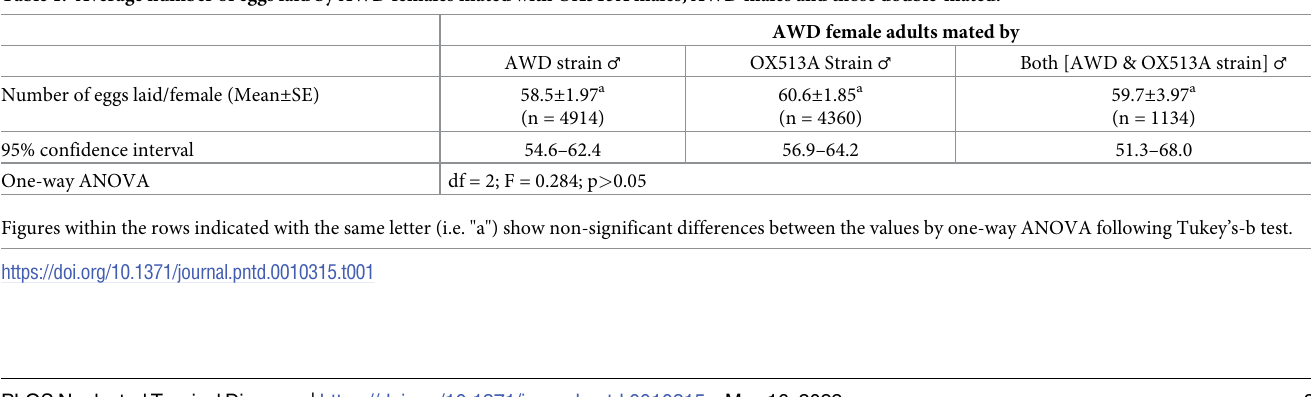
Table 1. Average number of eggs laid by AWD females mated with OX513A males, AWD males and those